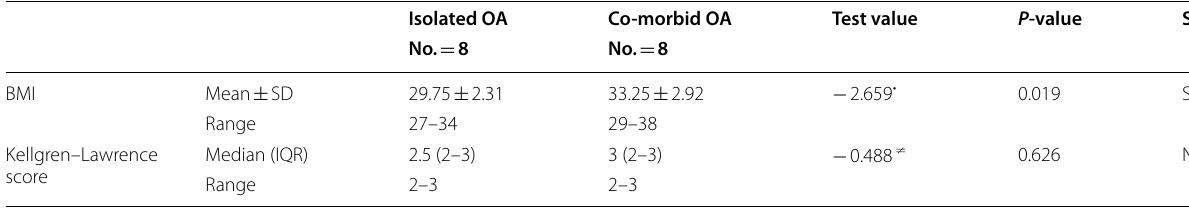
P -value > 0.05: Non-significant; P -value < 0.05: Significant; P -value < 0.01: Highly significant